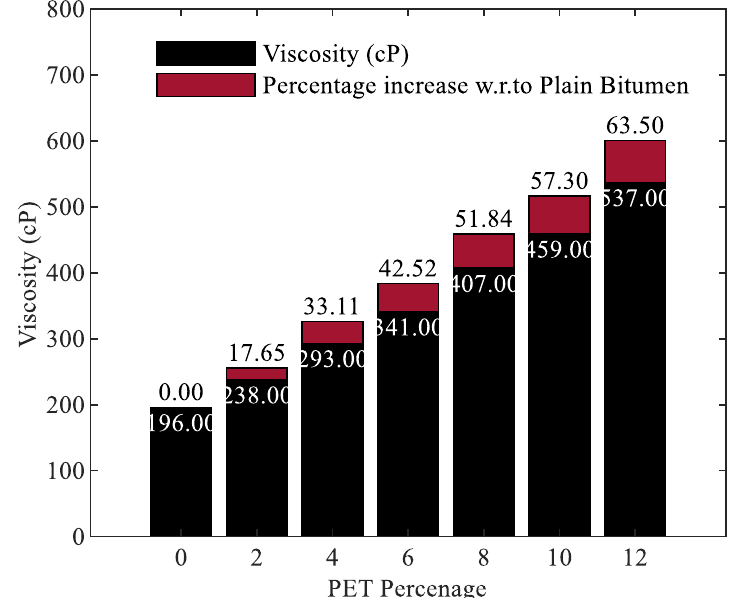
Fig. 19 Variation of viscosity with PET